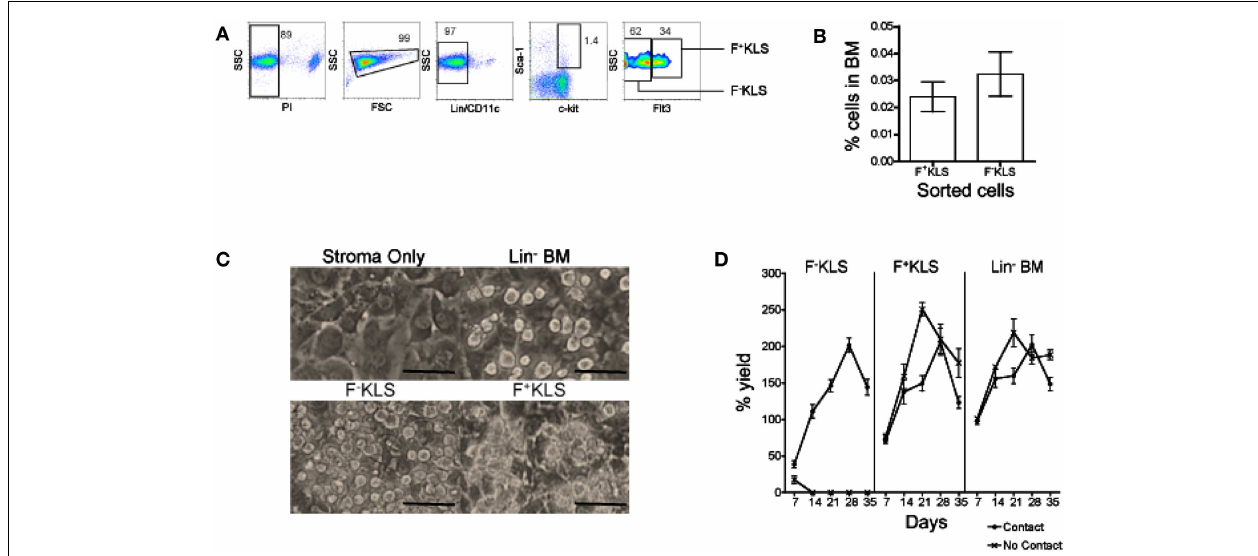
FIGURE 4 | Establishment of productive 5G3 co-cultures with HSC. Lin − BM was prepared using magnetic bead technology. Cells were then stained with a lineage antibody cocktail and antibodies specific for CD11c, c-kit, Sca-1, and Flt3 ahead of sorting to isolate HSC. (A) HSC were sorted as PI − Lin − CD11c − c-kit + Sca-1 + Flt3 − cells (F − KLS), and PI − Lin − CD11c − c-kit + Sca-1 + Flt3 + (F + KLS) cells. Gates were set using isotype controls, and numbers in gates represent % positive cells. (B) Recovery of HSC subsets from BM in